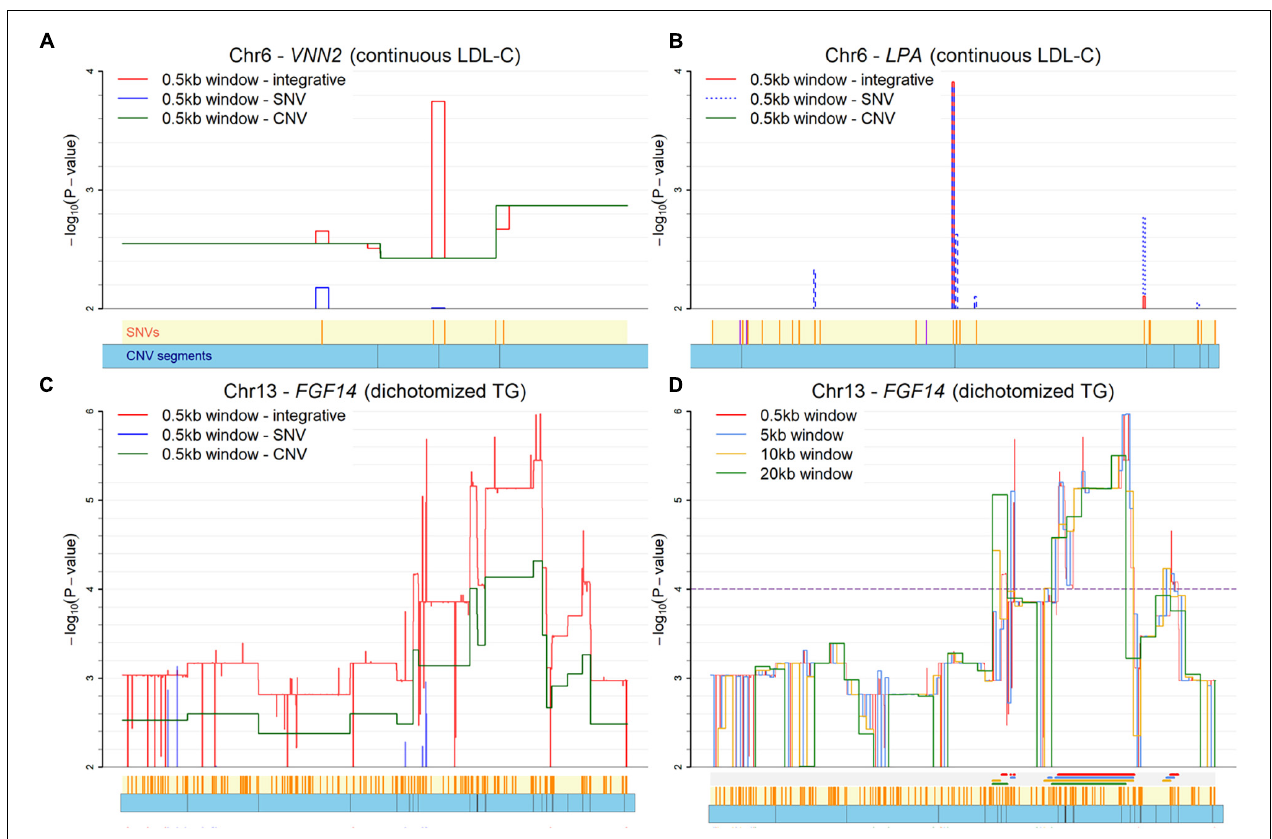
FIGURE 5 | Plot of co-localization analysis. (A) The VNN2 gene for LDL-C. (B) The LPA gene for LDL-C. (C) The FGF14 gene for TG with three platforms (SNV-only, CNV-only, and both). (D) The FGF14 gene for TG with four window sizes. Below each X -axis, the orange ticks inside the yellow region indicate positions of SNVs and the blue bars below it represent the CNV segments. Extra color lines below the X -axis in panel (D) denote the identified association regions ( p < 0.0001) under different window